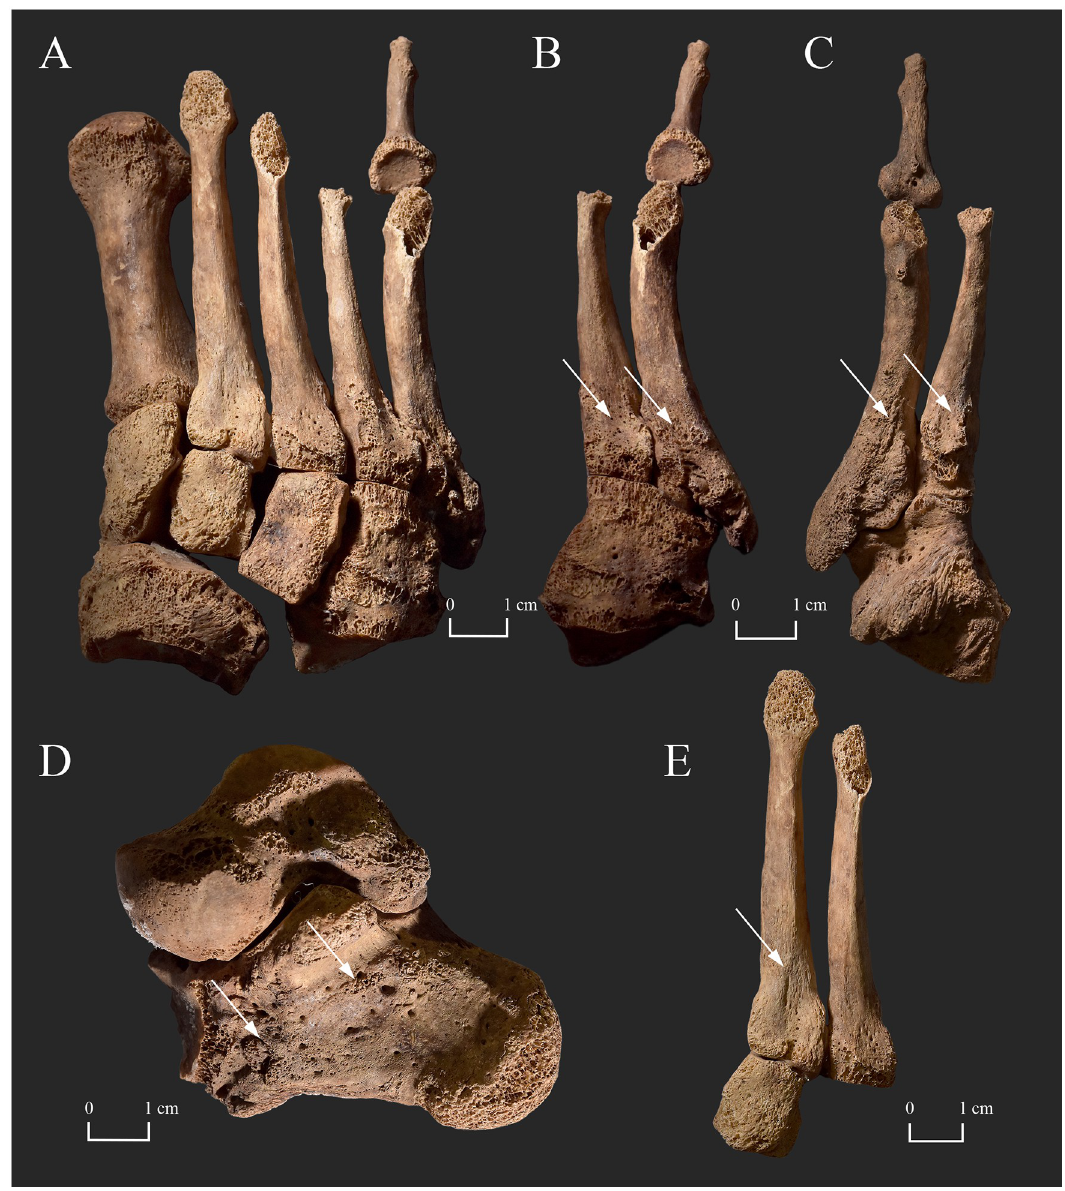
Fig 10. Bony changes indicative of leprosy in the tarsal bones and metatarsals of KD520. A) Concentric diaphyseal atrophy of the right 2 nd , 3 rd , and 4 th metatarsals (knife-edge type), and the right 5 th proximal phalanx (true pan-circumferential concentric type); B) Concentric diaphyseal atrophy of the right 4 th metatarsal (knife-edge type) and the right 5 th proximal phalanx (true pan- circumferential concentric type), and subperiosteal new bone formations on the proximal end of the right 4 th and 5 th metatarsals (dorsal surface–white arrows); C) Concentric diaphyseal atrophy of the right 5 th proximal phalanx (true pan-circumferential concentric type), and subperiosteal new bone formations on the proximal end of the right 4 th and 5 th metatarsals (plantar surface– white arrows); D) Pitting and subperiosteal new bone formations on the medial surface of the right calcaneus (white arrows); and E) Slight surface pitting on the proximal end of the right 2 nd and 3 rd metatarsals (dorsal surface–white arrow). syndrome’ [49]. This set of lesions (S2 Text) is caused by local invasion of the affected bone(s) by leprosy bacilli [11, 20]. It can happen through direct extension of the infection from the adjacent soft tissues, such as the overlying skin and oronasal mucosa, or via haematogenous spread of the pathogens [11, 20, 55]. The rhinomaxillary syndrome is a composite mixture of